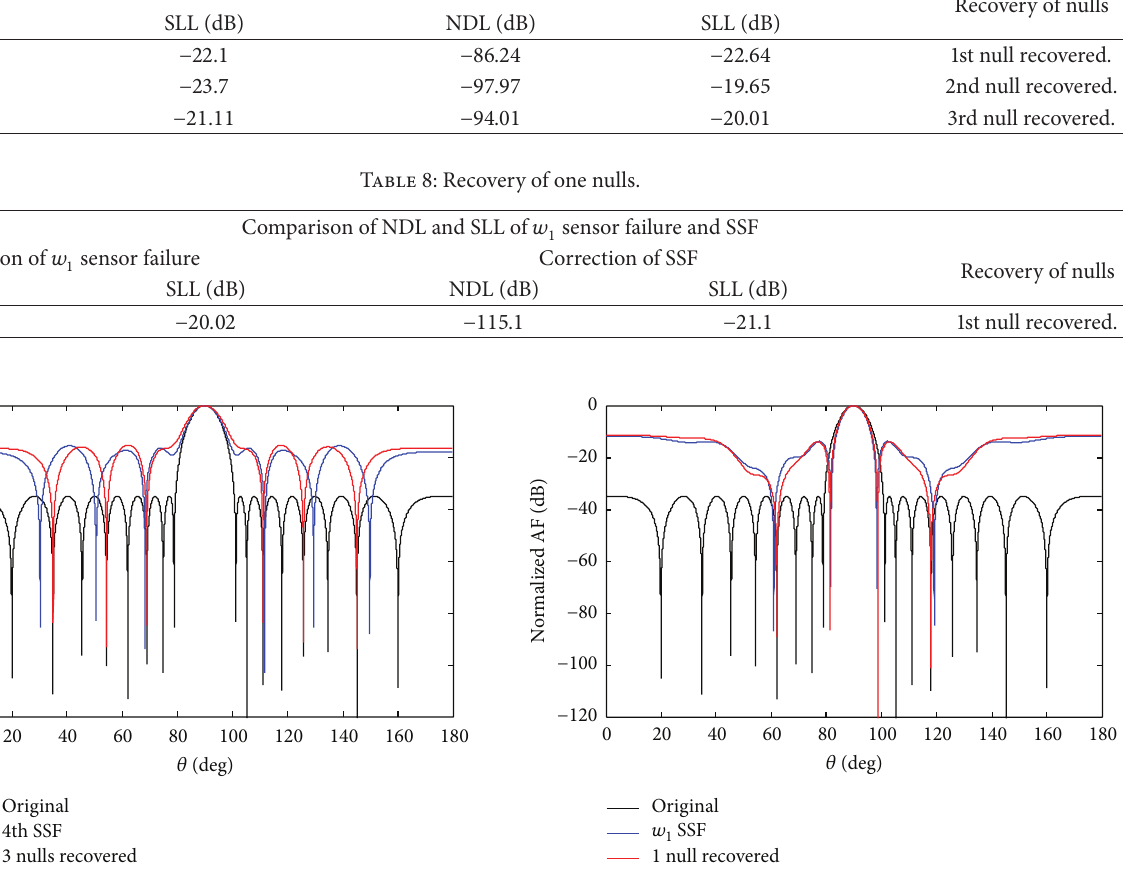
Figure 13: The original radiation pattern, the 𝑤 4 SSF, and recovery of three nulls.